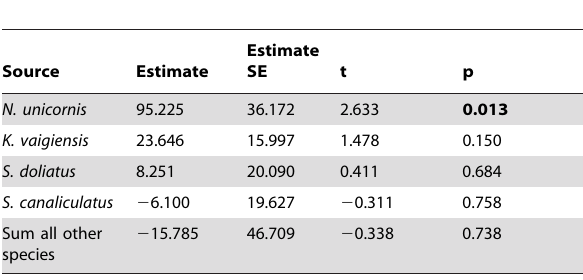
Table 2. Results of multiple regression analysis on the relationship between algae biomass loss in the Keppel Islands and the standardised bite rate of the four species responsible for . 5% of all bites and all other species pooled together.